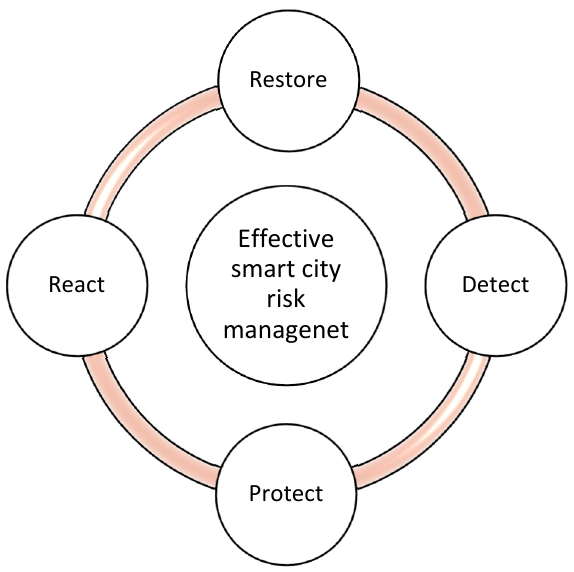
Figure 3. Smart city risk-management model adapted by PwC (2020).